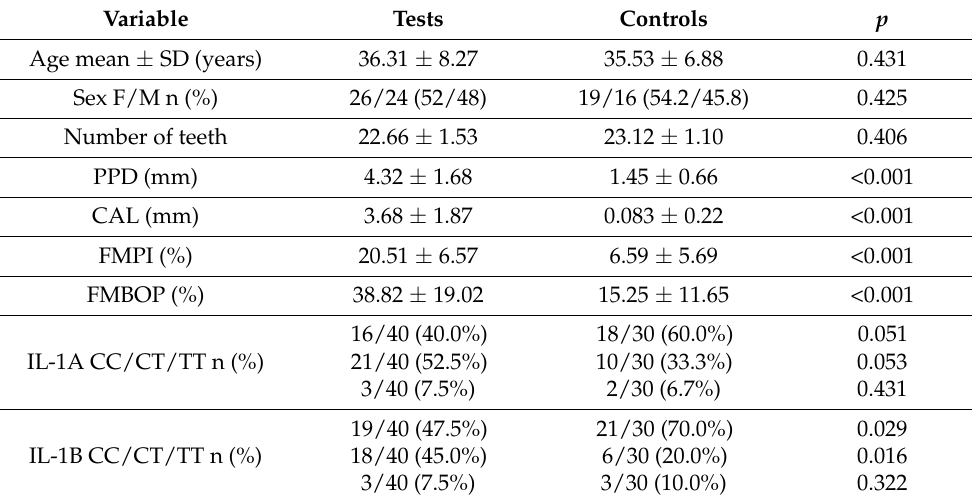
Table 1. Demographic and clinical characteristics of tests and